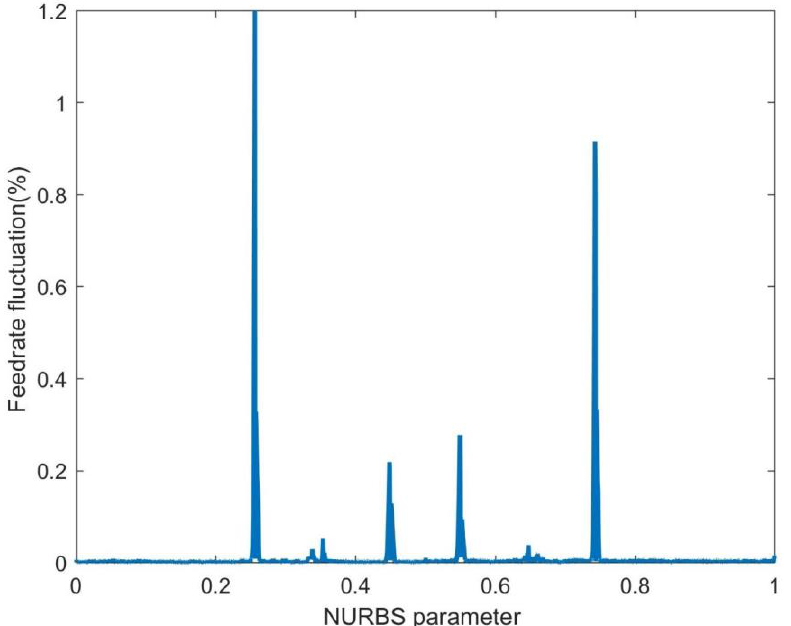
Figure 6. The feedrate fluctuation of the FAM with the first-level parameter compensation.